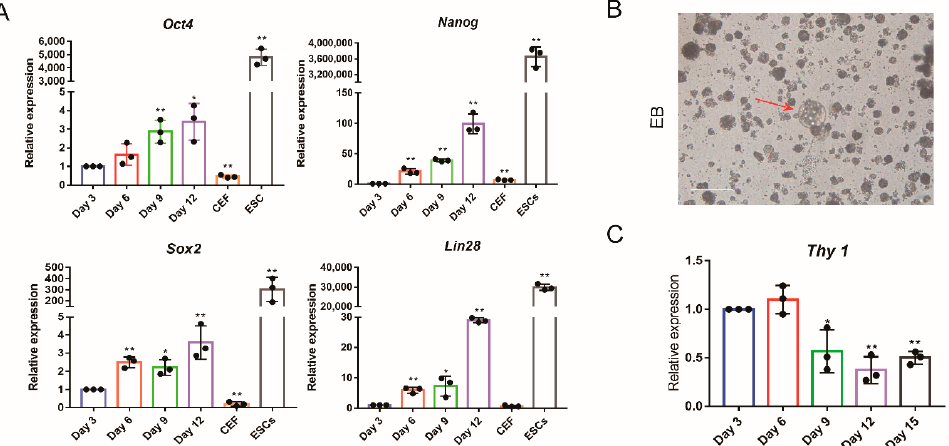
Figure 2. Pluripotency of chicken iPSCs. ( A ) qRT- PCR analysis of expression of endogenous pluripotent genes Oct4 , Sox2 , Nanog and Lin28 in CEF transduced with OSNL reprogramming cocktail. ( B ) Embryoid body formation in vitro. Scale bars = 100 µm. ( C ) qRT-PCR analysis of expression of somatic marker gene Thy1 in CEF transduced with OSNL reprogramming cocktail. * represents p < 0.05 and ** represents p < 0.01.